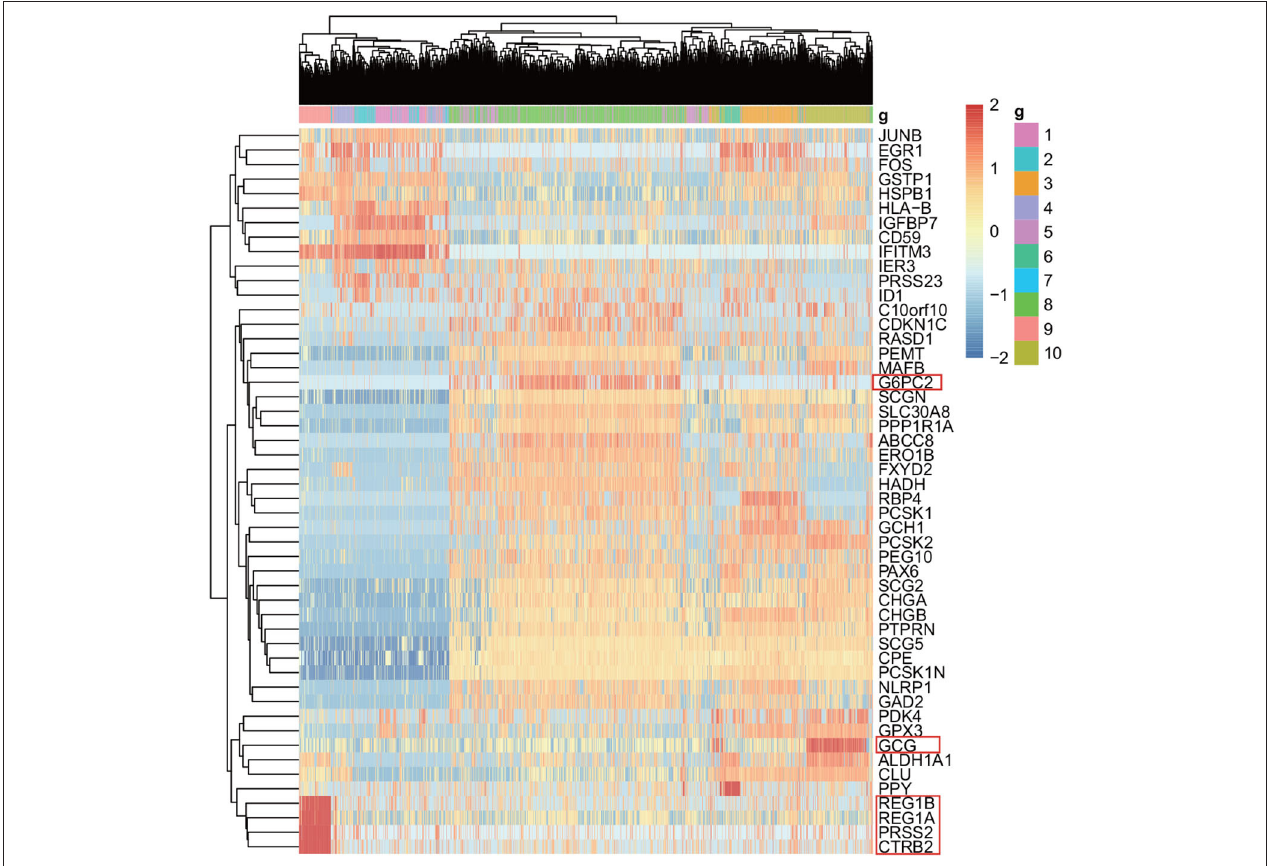
FIGURE 9 | The heat map shows the top 50 standard deviation genes in the Baron-human1 experimental results. Each row represents the genes and each column represents the cells.